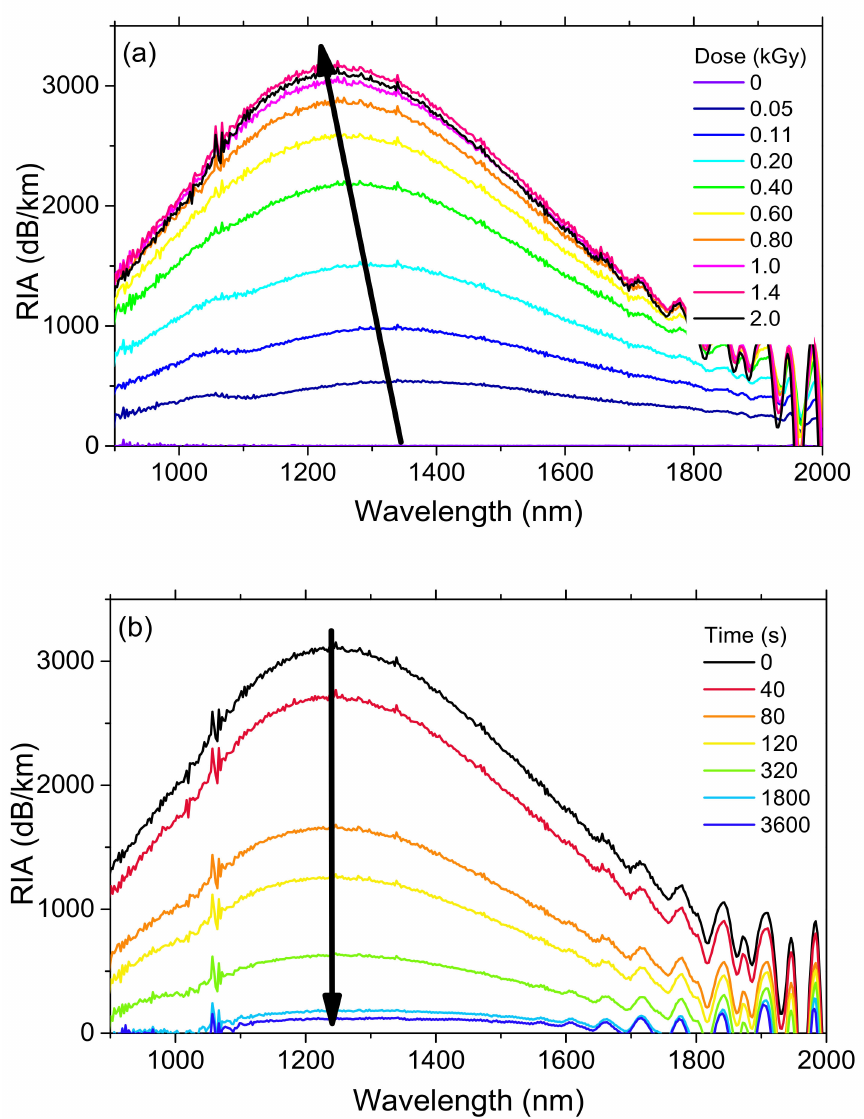
Figure 6. ULL-PSC spectral RIA ( a ) as a function of the dose during the irradiation and ( b ) as a function of the time delay from the irradiation end during the recovery phase, the dose-rate being 175 mGy / s. The arrows indicate the time that